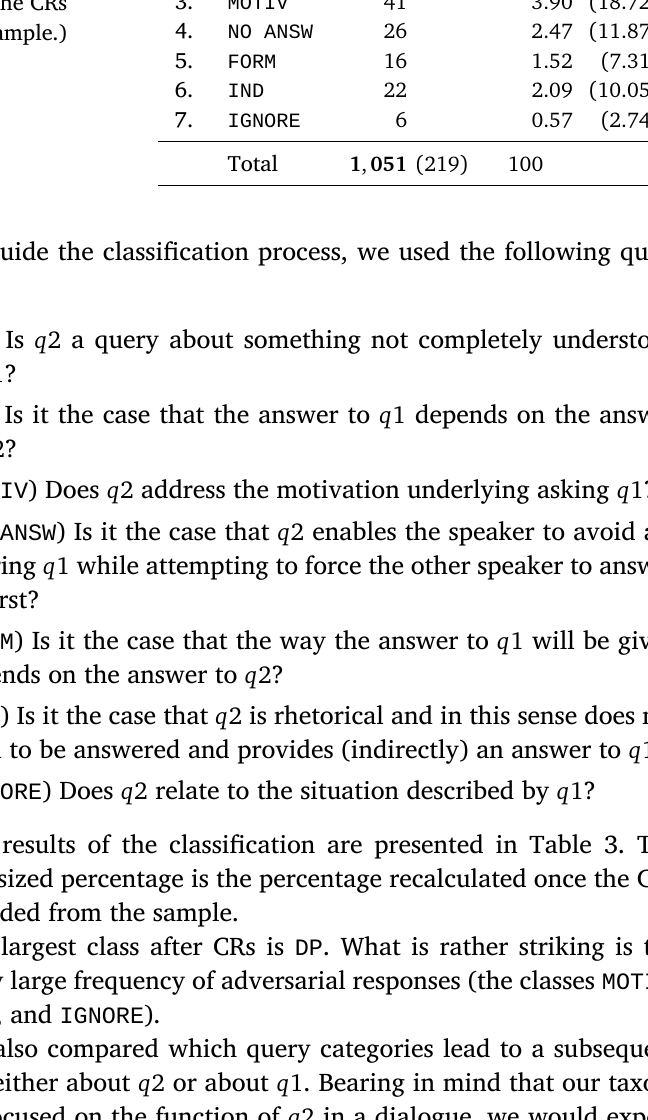
Table 3: Frequency of query – query response categories in the BNC (The parenthesized percentage is the percentage recalculated once the CRs are excluded from the